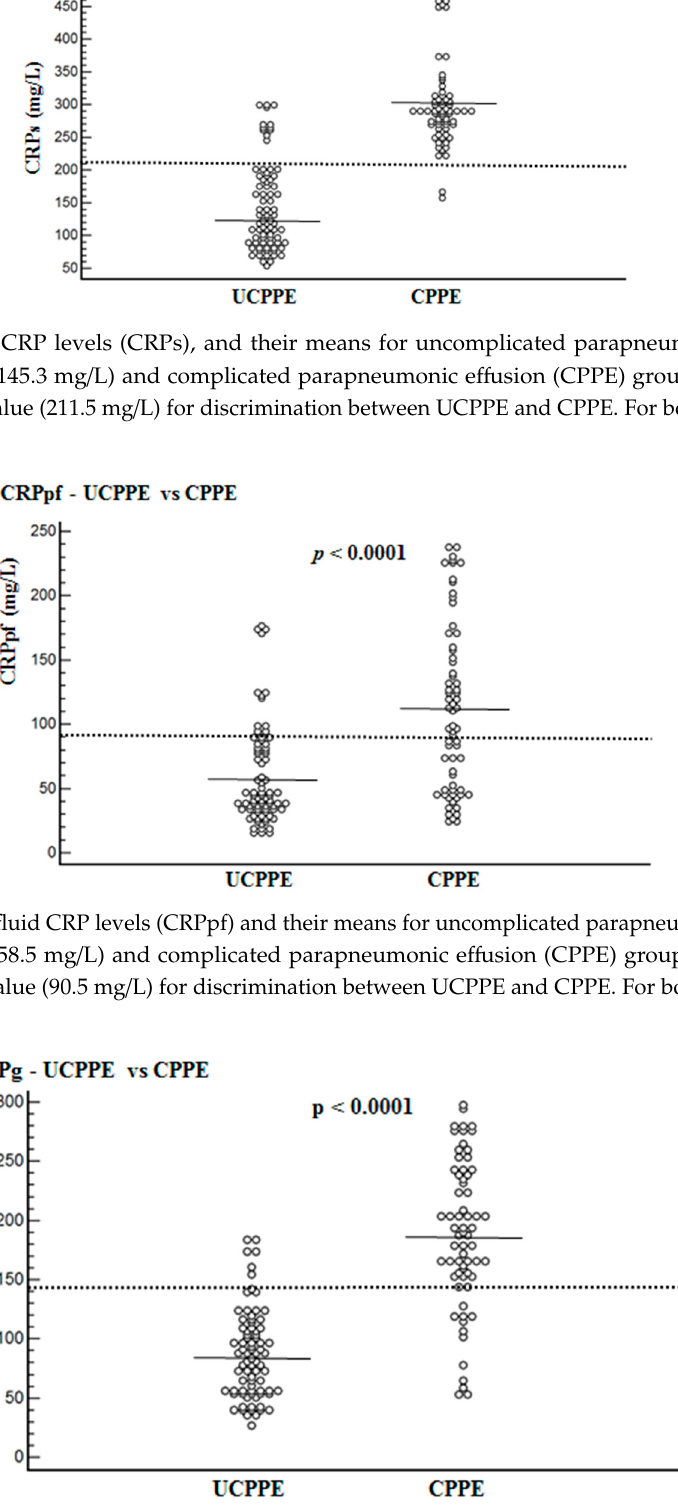
Figure 3. Serum and pleural fluid CRP gradient (CRPg) levels for uncomplicated parapneumonic effusion (UCPPE) group (86.9 mg/L) and complicated parapneumonic effusion (CPPE) group (188.3 mg/L), and best cut-off value (142 mg/L) for discrimination between UCPPE and CPPE. For both parameters p < 0.0001.